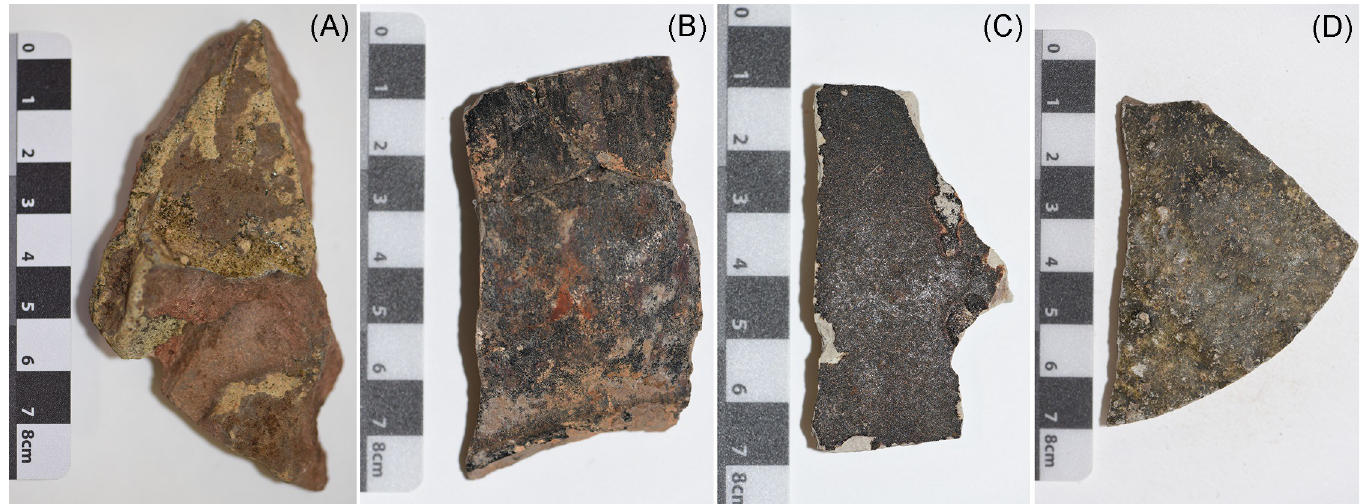
Fig 3. Trade ceramics at Longvek. (A) Sisatchanalai brown-glaze stoneware sherd (BGC028, Central occupation mound—Trench 15). (B) Bang Rachan brown-glaze stoneware sherd (BGC097, Wat Tralaeng Kaeng—Trench 23). (C) South China brown-glaze stoneware sherd (BGC100, Wat Tralaeng Kaeng—Trench 23). (D) Cambodian brown-glaze stoneware sherd (BGC078, Central occupation mound—Trench 21). Image credits: Catherine Morton.